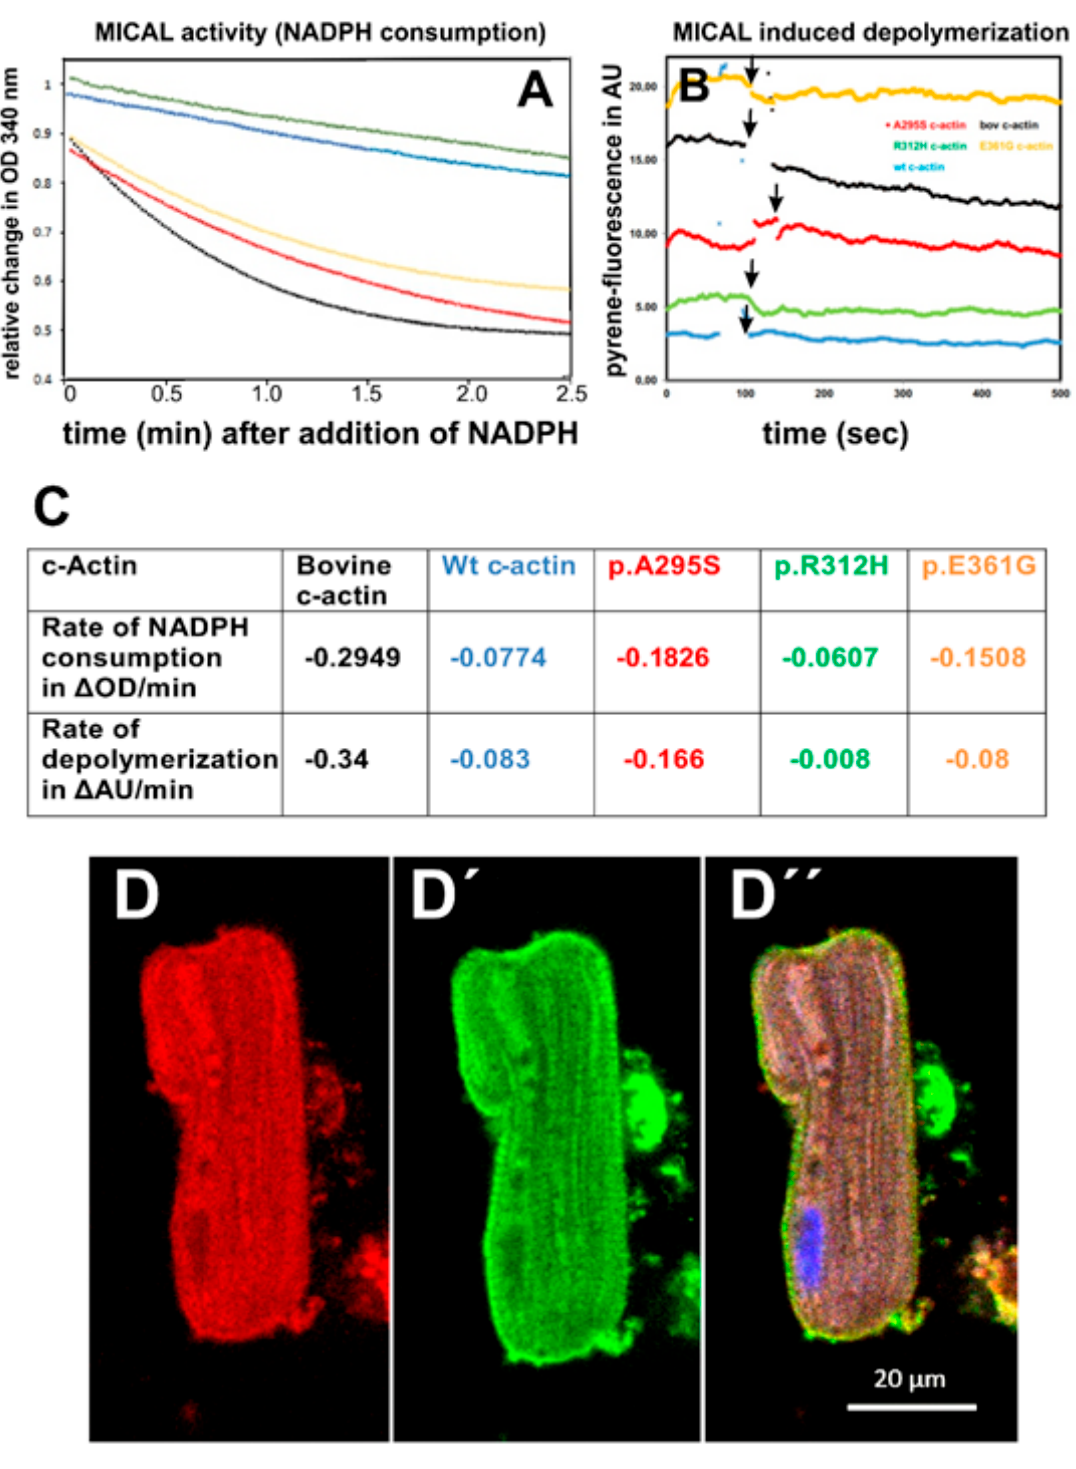
Figure 3. Influence of the monooxidase MICAL-1 on cardiac actin variants. ( A ) Rates of oxidation of c-actin variants by MICAL-1 as measured by substrate NADPH consumption determined optically at 340 nm (for details, see text). Cardiac actins at 1 µ M were with 0.5 µ g of the N-terminal domain of MICAL-1 in 5 mM HEPES buffer, pH 7.4, supplemented with 2 mM MgCl 2 and 20 µ M NADPH. Bovine c-actin ( __ ); wt recombinant c-actin ( __ ); p.A295S ( __ ); p.R312H) ( __ ); p.E361G ( __ ). ( B ) Oxidation of the F-c-actin variants by MICAL-1 induced their de-polymerization. Representative experiments from three for every c-actin variant. ( C ) Table of the rates determined for the oxidation of the c-actins ( A ) and their de-polymerization ( B ). ( D ) Double immunostaining of ARCs with a mouse anti-MICA-L1 antibody and ( D’ ) with a rabbit anti-actin antibody. ( D” ) Merged image together with nuclear Hoechst 33342 staining. Bar corresponds to 20 µ